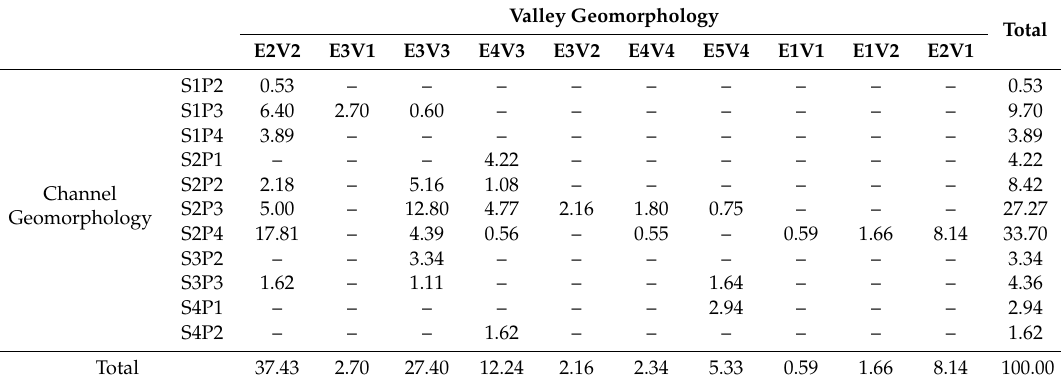
Table 13. Percentages (%) of occupancy of types of riverbed and valley in the two HAL-MWs in Molinopampa (Amazonas, Peru).